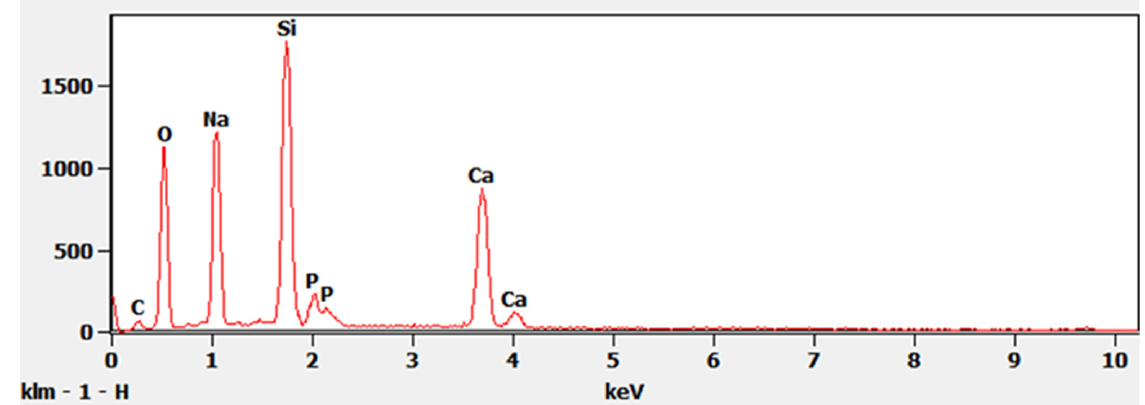
Figure 5. EDS spectra showed the presence of Na, Si, P, and Ca in the sintered BG.